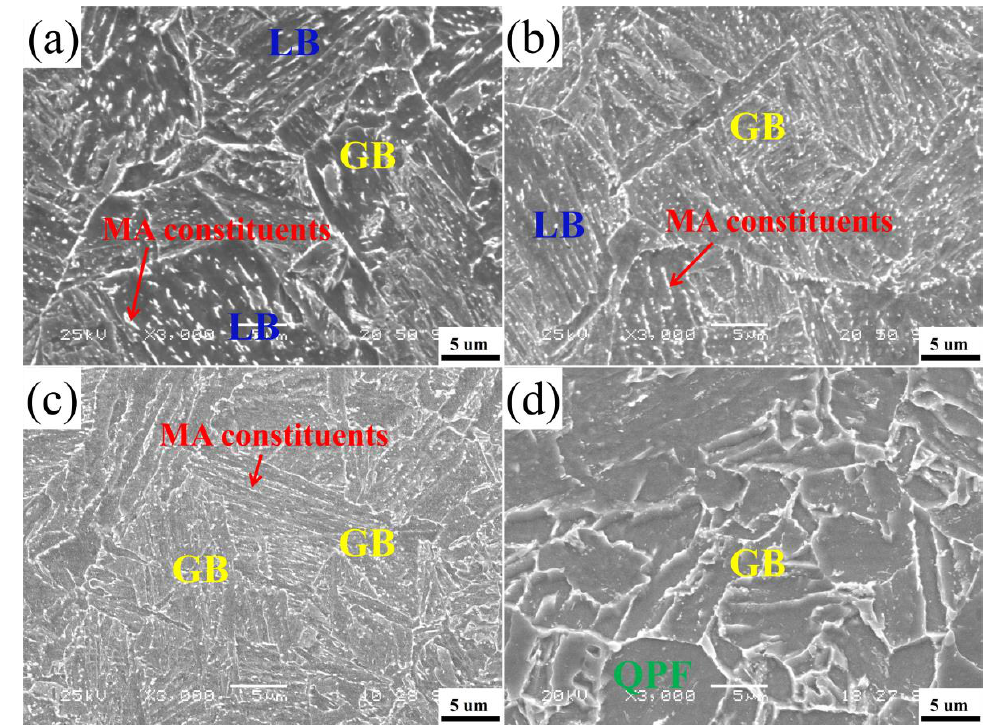
Figure 5. SEM micropraphs of heavy-wall seamless bend pipe steel after tempering at ( a ) 550 °C , ( b ) 600 °C , ( c ) 650 °C , and ( d ) 700 °C .